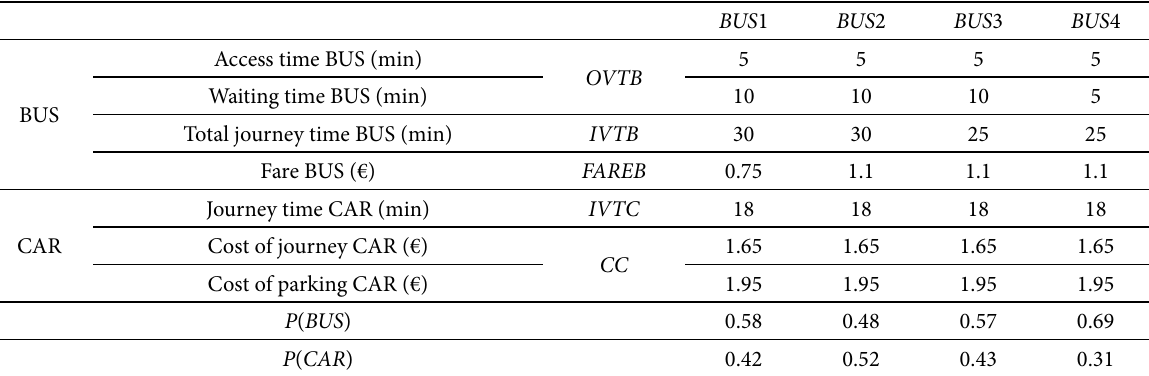
Table 11. Bus vs. Car situations